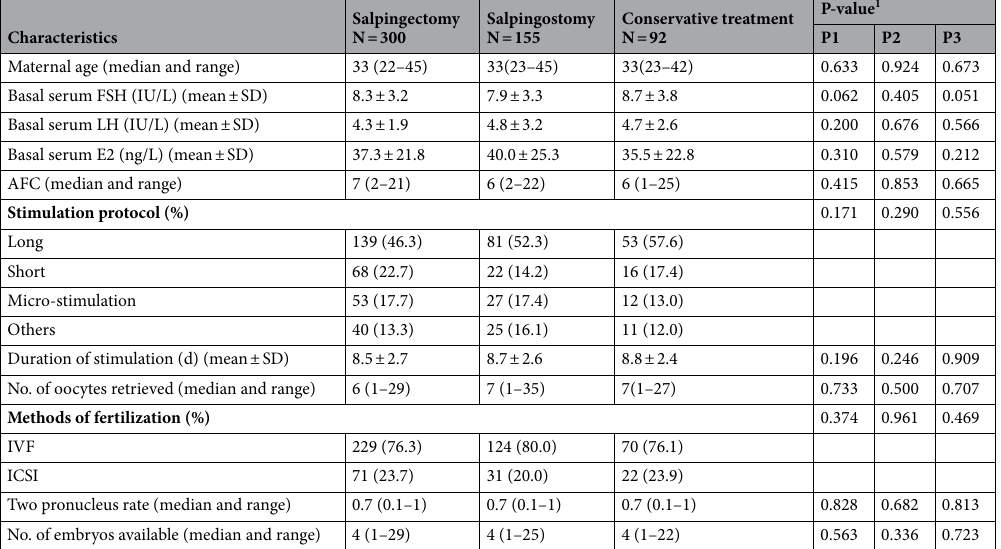
Table 5. Cycle characteristics of patients with previous ectopic pregnancy according to treatments. 1 We defined the statistical outcomes of salpingectomy group versus salpingostomy group as P1; salpingectomy group versus conservative treatment group as P2; salpingostomy group versus conservative treatment group as